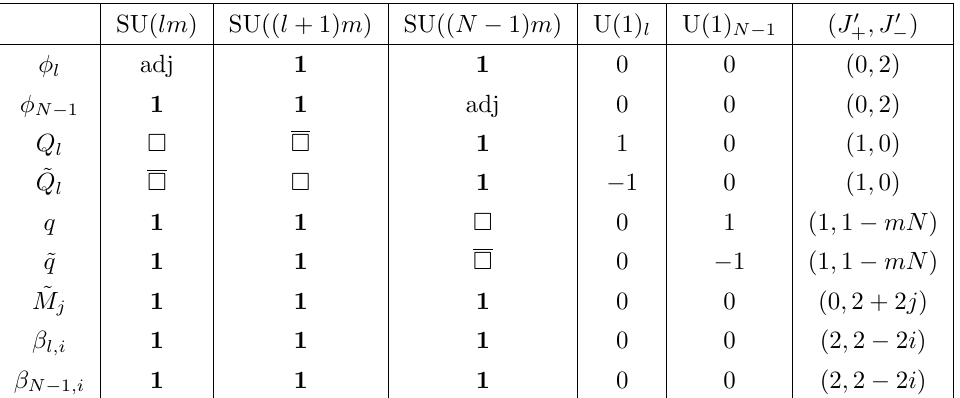
Table 3. The charges of fields in the Lagrangian description of the ( A N − 1 , A The gauge group and matter content with l = N − 1 have been singled out, such that in the table l runs over 1 , . . . , N − 2 . The columns before the double vertical lines are the gauge groups in the quiver, and the remaining three columns are the baryonic global symmetries and R-charges. The operators ˜ M that remain coupled at the fixed point have j = m + 1 , . . . , mN − 1 . The singlets j β l,i are flipping fields, where for l = 1 i runs over 2 , . . . , m , and for l = 2 , . . . , N − 1 i runs over 2 , . . . , m + 1